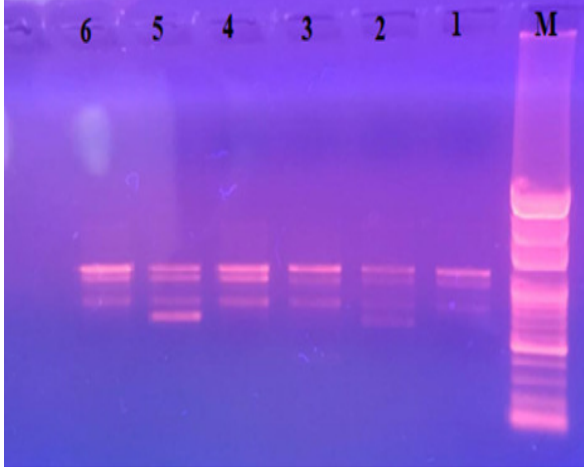
Fig. 1. Gel image of RAPD-PCR bands amplified with OPA- Fig. 2. Gel image of RAPD-PCR bands amplified with OPA-